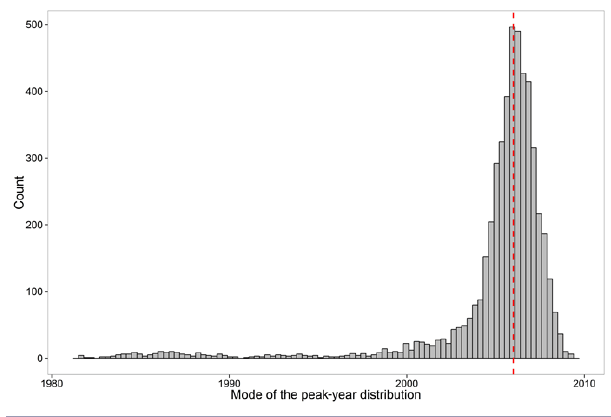
Fig. 4 . Synchrony of the peak-rate years is evident. For each of the 16 out of 20 statistically independent global resources showing a peak-rate year, one peak-rate year out of the 5000 from the bootstrap resample was randomly selected. The mode of the resulting smoothed distribution of 16 peak-rate years was obtained, and the process repeated 5000 times resulting in the mode histogram, with a median of 2006 (1989-2008) in red. A nonparametric goodness of fit test rejected (P < 0.001) the two-sided null hypothesis that the histogram was sampled from a uniform distribution (i.e., no